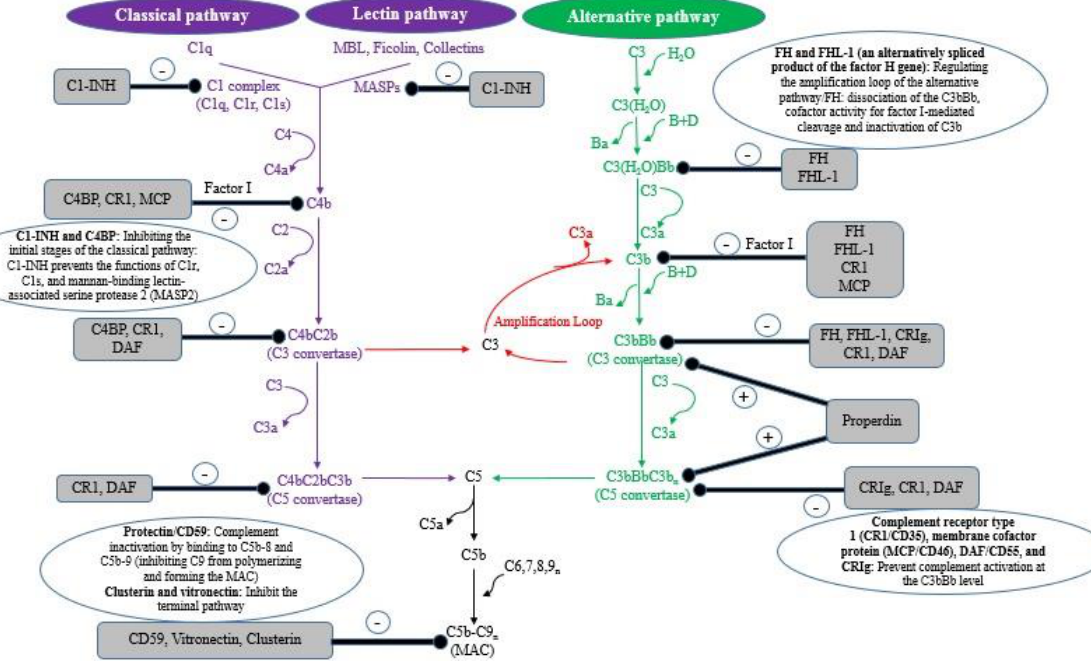
Figure 1. The activation of complement system: (a) the classical pathway is induced by the recognition of antibody-antigen complexes on the pathogens surfaces through (by interacting with) complement component C1q, then cleaving C2 and C4 to produce C2a and C4b; these complement components bind to the pathogens surface to compose the C3 convertase C4b2a. (b) The lectin pathway in triggered by binding the mannose-binding lectin (MBL) or ficolin to mannan or glycosylated biomolecules, respectively (on the pathogens surface). The interaction of cysteine proteases with these biomolecules drive to the cleavage of C2 and C4 and thus generate the C3 convertase C4b2a. (c) The alternative pathway is initiated by spontaneously hydrolyzing C3b or C3b obtained from the other pathways, interacting with factor B, which is cleaved into Bb through factor D, and consequently composing the C3 convertase C3bBb [6,7].